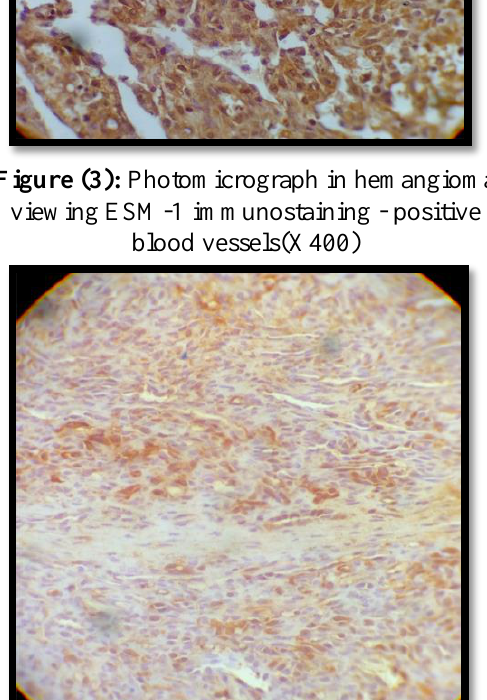
Figure (4): Photomicrograph in lobular capillary hemangioma viewing ESM-1 immunostaining- positive blood vessels (X200)